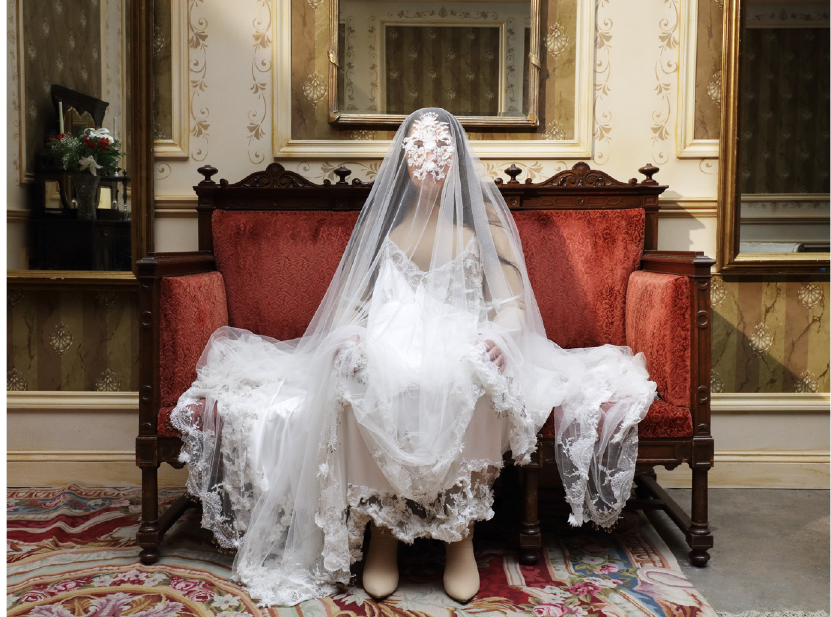
Fig. 2 Marina Abramov ić , 7 Deaths of Maria Callas , 2019. Photo credit: Marco Anelli, courtesy of the Marina Abramovi ć